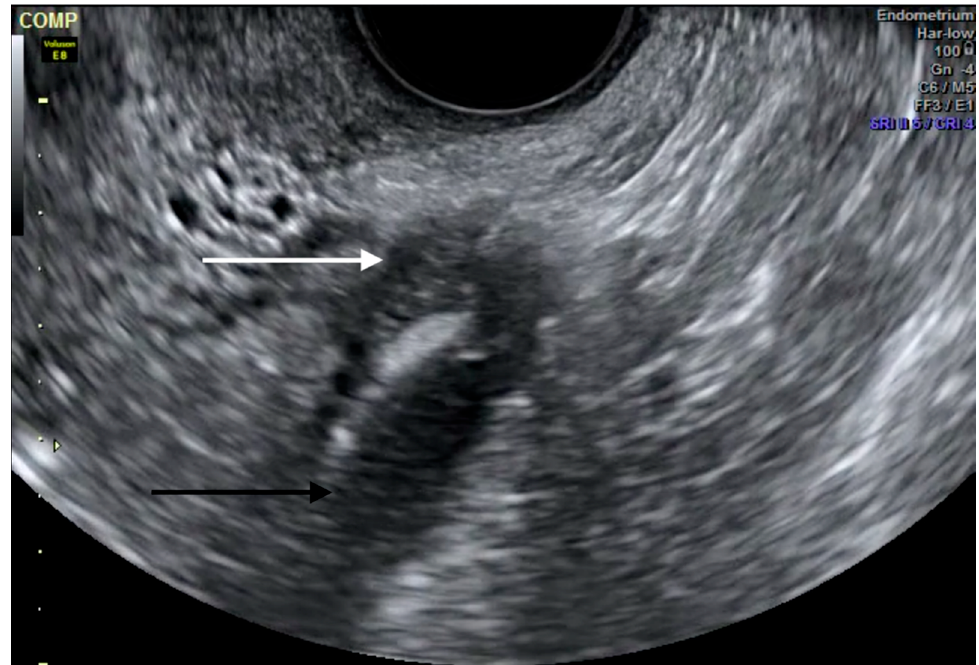
Figure 4. Transvaginal ultrasound depiction of ureteral deep endometriosis nodule (white arrow) and hydroureter (black arrow). The nodule originates from the uterosacral ligament but infiltrates the parametrium and extrinsically compresses the ureter.